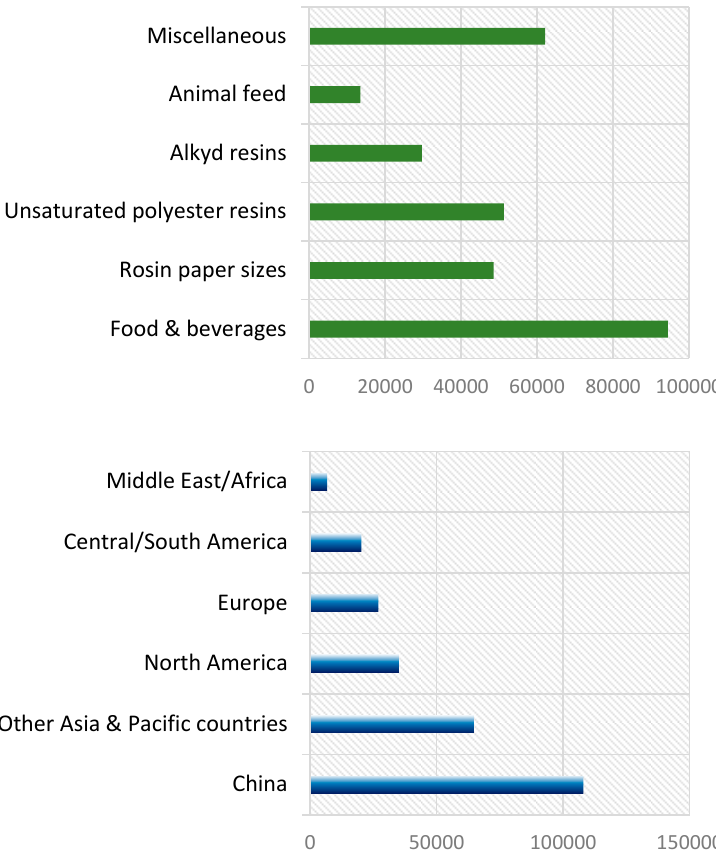
Figure 1. Fumaric acid consumption regarding its applications (in the upper graph) and countries/world regions (in the lower graph) [14].